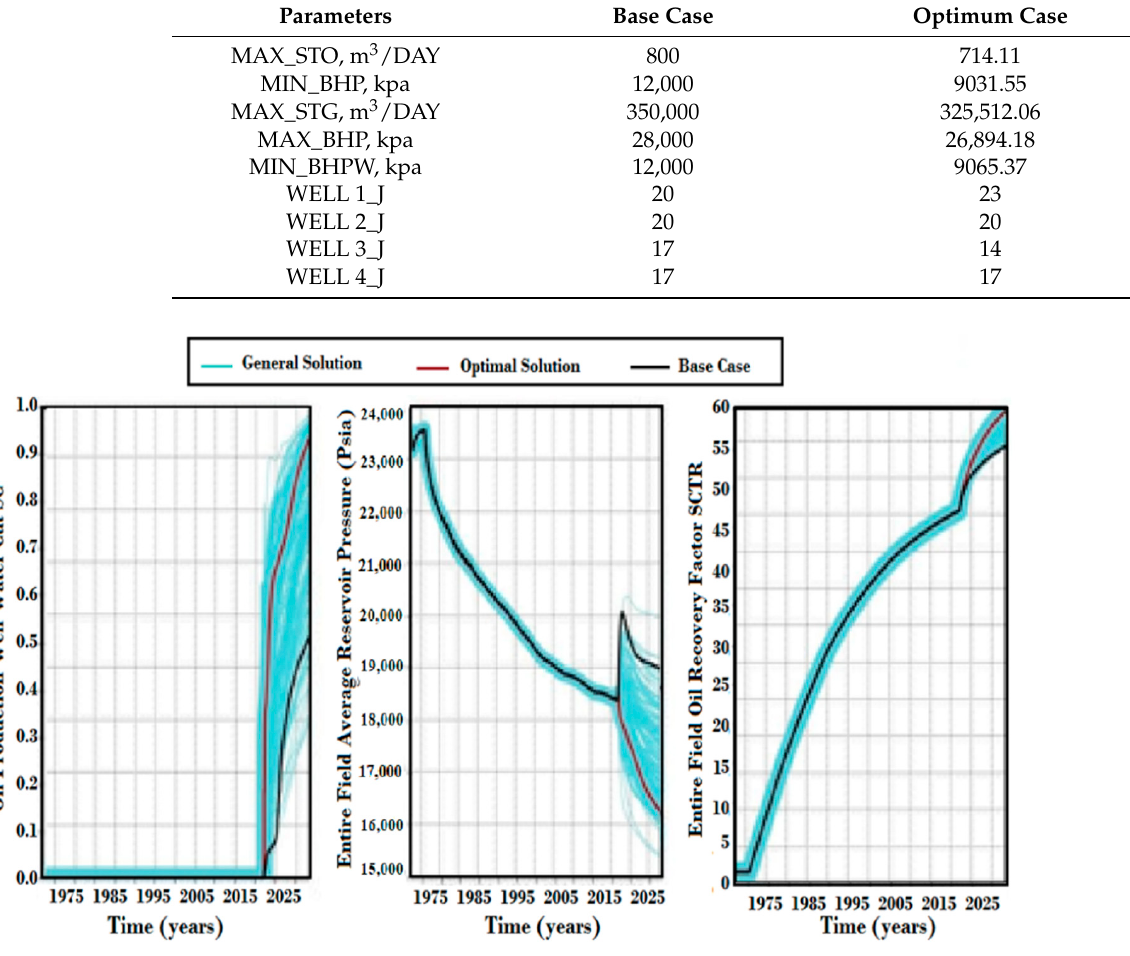
Figure 15. PSO-optimal flow responses considering 500 cases for scenario 2. Left: oil well water cut; middle: average reservoir pressure; and right: oil recovery factor. Table 5. Base-case and PSO-derived optimal-case operational decision variable values for TC-GDWS recovery optimization applied to scenario 2.